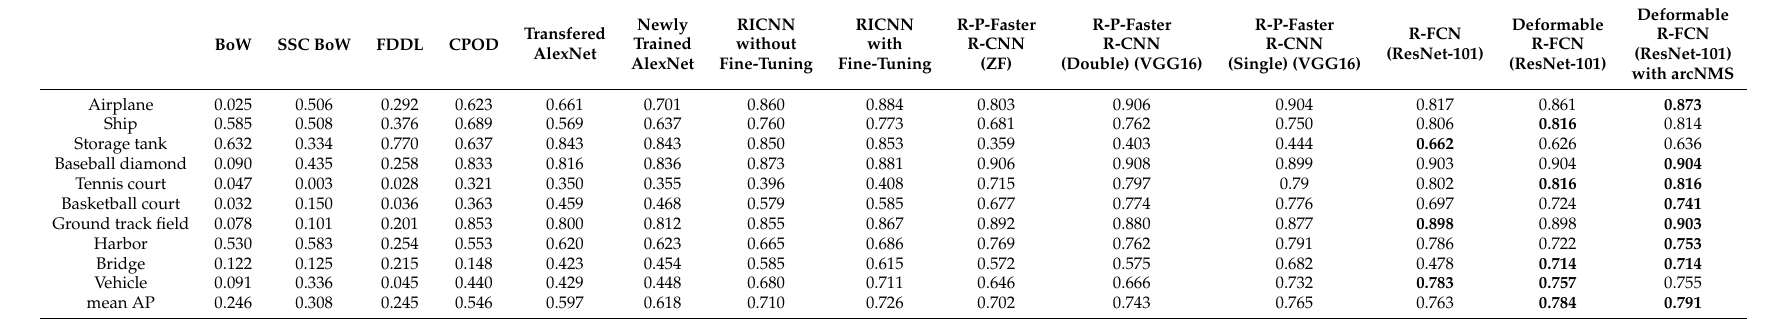
Table 1. The AP (Average Precision) values of the object detection methods.